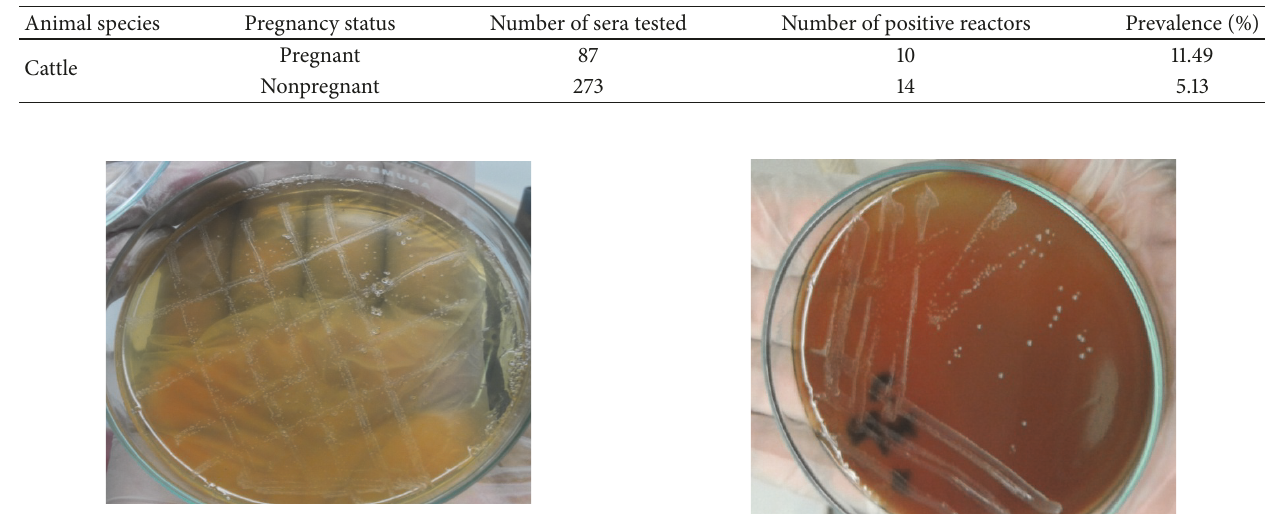
Table 5: Seroprevalence of brucellosis in cattle on the basis of pregnancy status.